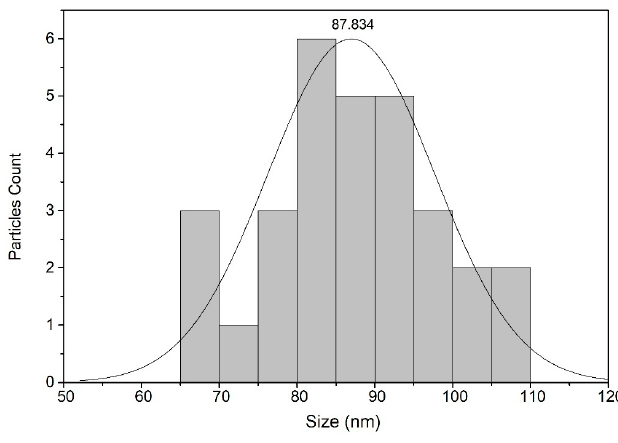
Figure 2. FESEM image for dry CNC.